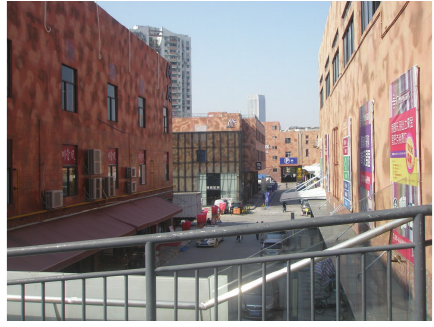
Figure 8: A view of Xingang 82.